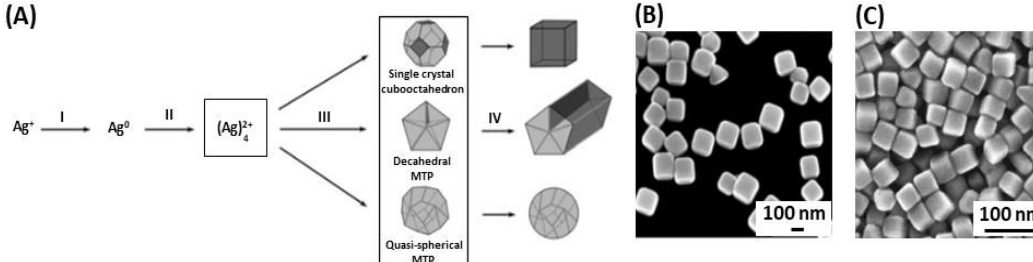
8 of 40 Figure 5. Diagram of the nanosphere lithography (NSL) mechanism. SEM image of topography of the triangular Ag nanoparticles fabricated by NSL. Adapted from [96]. Copyright (2011), publisher and licensee Dove Medical Press Ltd. 2.3. AgNPs Synthesis: Chemical Reduction Using Unconventional Ligands In 2002, it was reported that silver nanocubes were synthesized with a polyol process (Figure 6A), which involves the reduction of silver thanks to the hydroxyl groups of ethylene glycol [82]. The alcohol acts both as solvent and reducing agent [54]. A capping agent is then added; generally